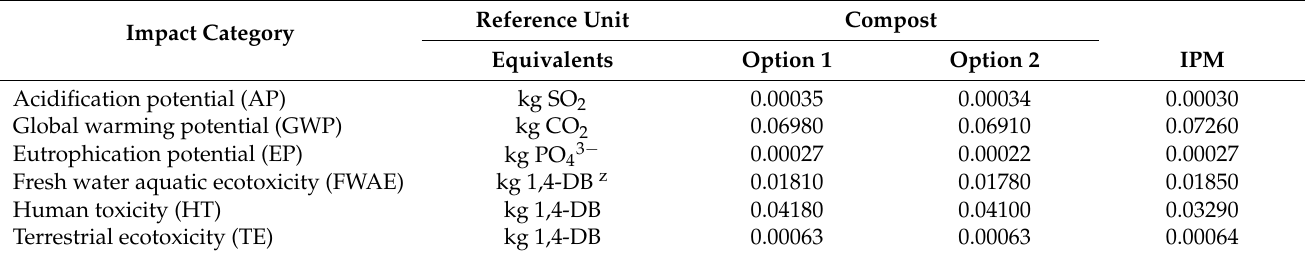
Table 3. Sensitivity analysis for one cyclamen plant subjected to alternative practices. In relation to garden waste compost addition to the growing medium in option 1, NPK content of compost does not replace fertilizers and in option 2 NPK content replaces part of the mineral fertilizers applied through fertigation. IPM = integrated pest management. Impact